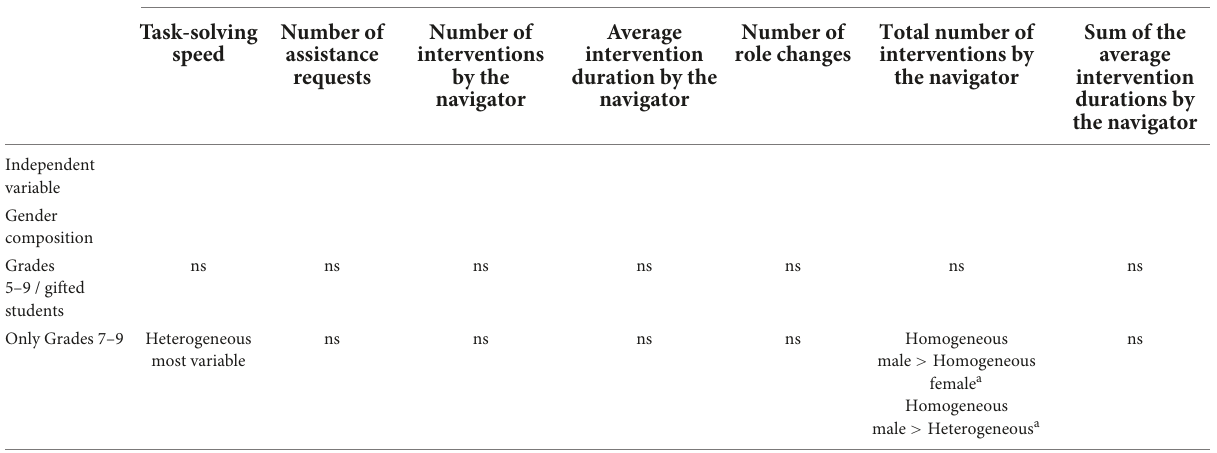
TABLE 5 Summary of results concerning the research